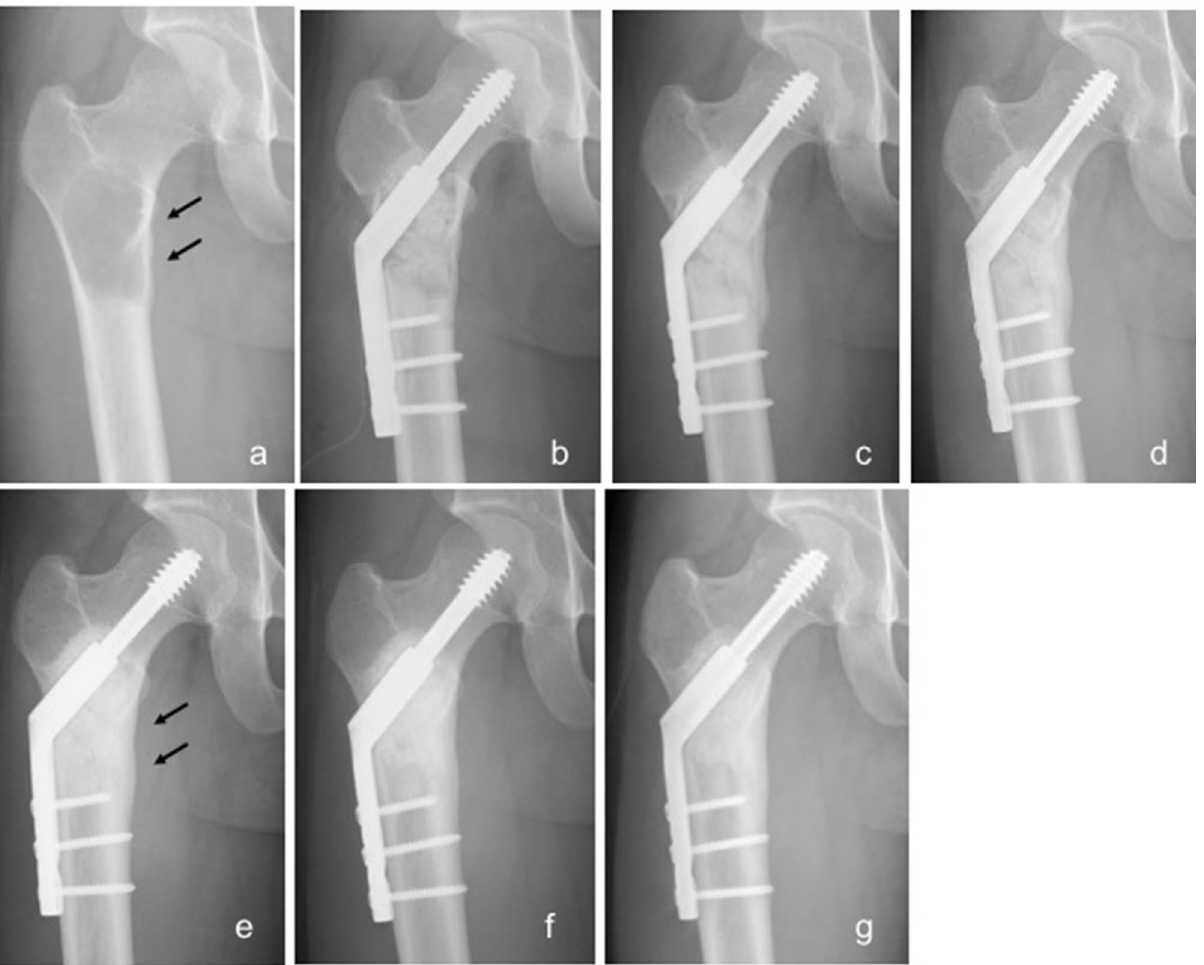
Figure 4. Radiographs of a 23-year-old simple bone cyst of the right proximal femur treated with both block-type and granule-type UDPHAp. ( a ) A lytic change with cortical thinning of the medial bone cortex (arrows) was identified. ( b ) UDPHAp implantation and internal fixation were conducted to prevent fracture. ( c ) Slight bone formation was seen 2 months postoperatively (stage 1). ( d ) Stage 2 radiographic change was confirmed 5 months postoperatively. ( e ) Regeneration of medial cortical thinning (arrows) was seen 10 months postoperatively. ( f ) Stage 3 was noted 19 months postoperatively. ( g ) UDPHAp absorption and bone marrow remodeling were confirmed 3 years postoperatively (Stage 4). The decrease of medial cortical thickness was completely